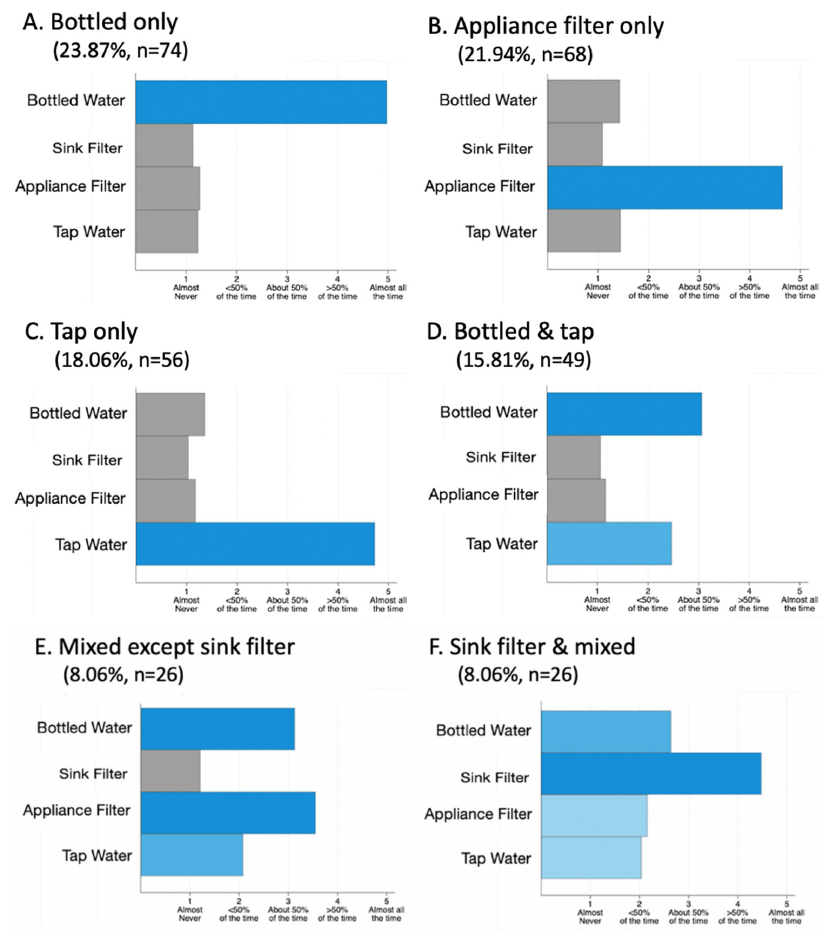
Figure 3. Means of the frequency of water source use for each cluster. Dark blue bars represent water source usage at or above 50% of the time . Medium blue bars represent water usage between <50% of the time and 50% of the time . Light blue bars represent water usage near <50% of the time. Grey bars represent water usage at or close to almost